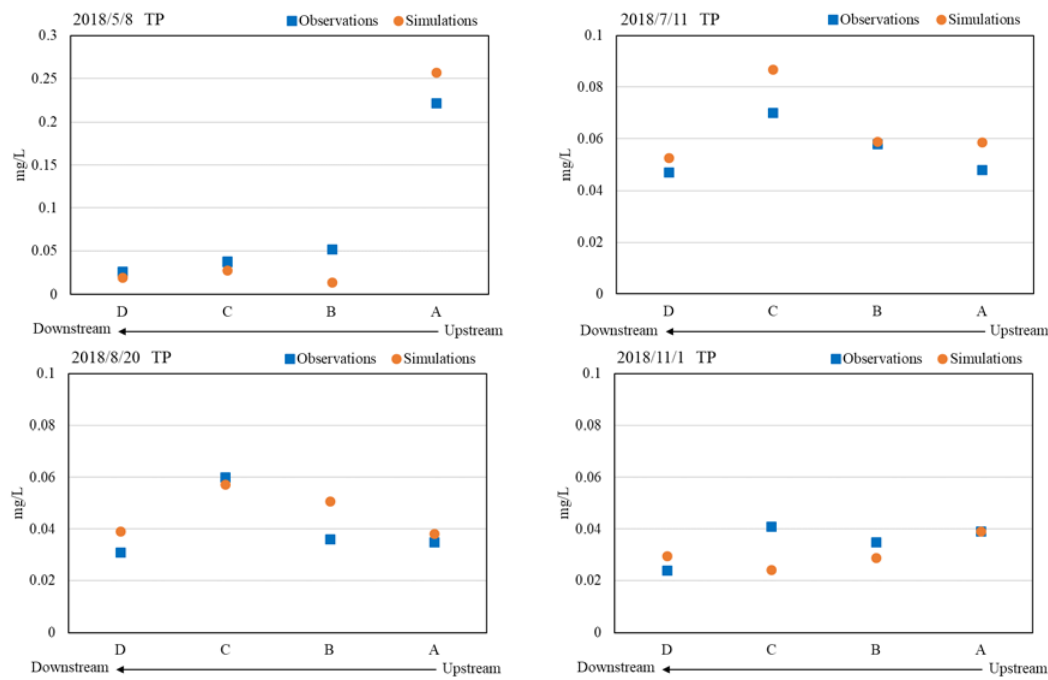
Figure 6. The total phosphorous (TP) simulations of dry weather events. The data of the 5/18 event are for calibration, and the other 6 events are for verification.